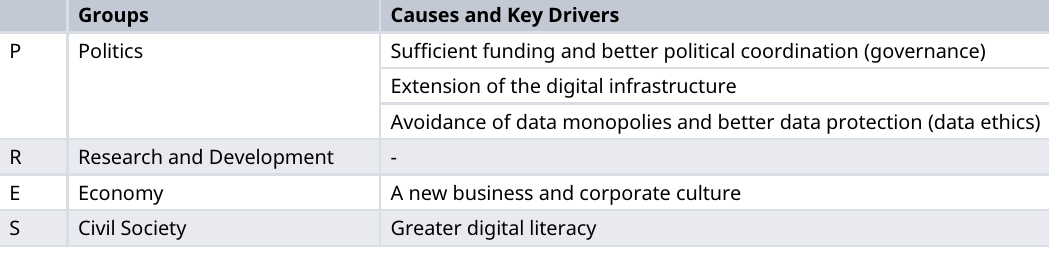
Table 3. Groups of stakeholders and assigned causes and drivers according to Goger et al.